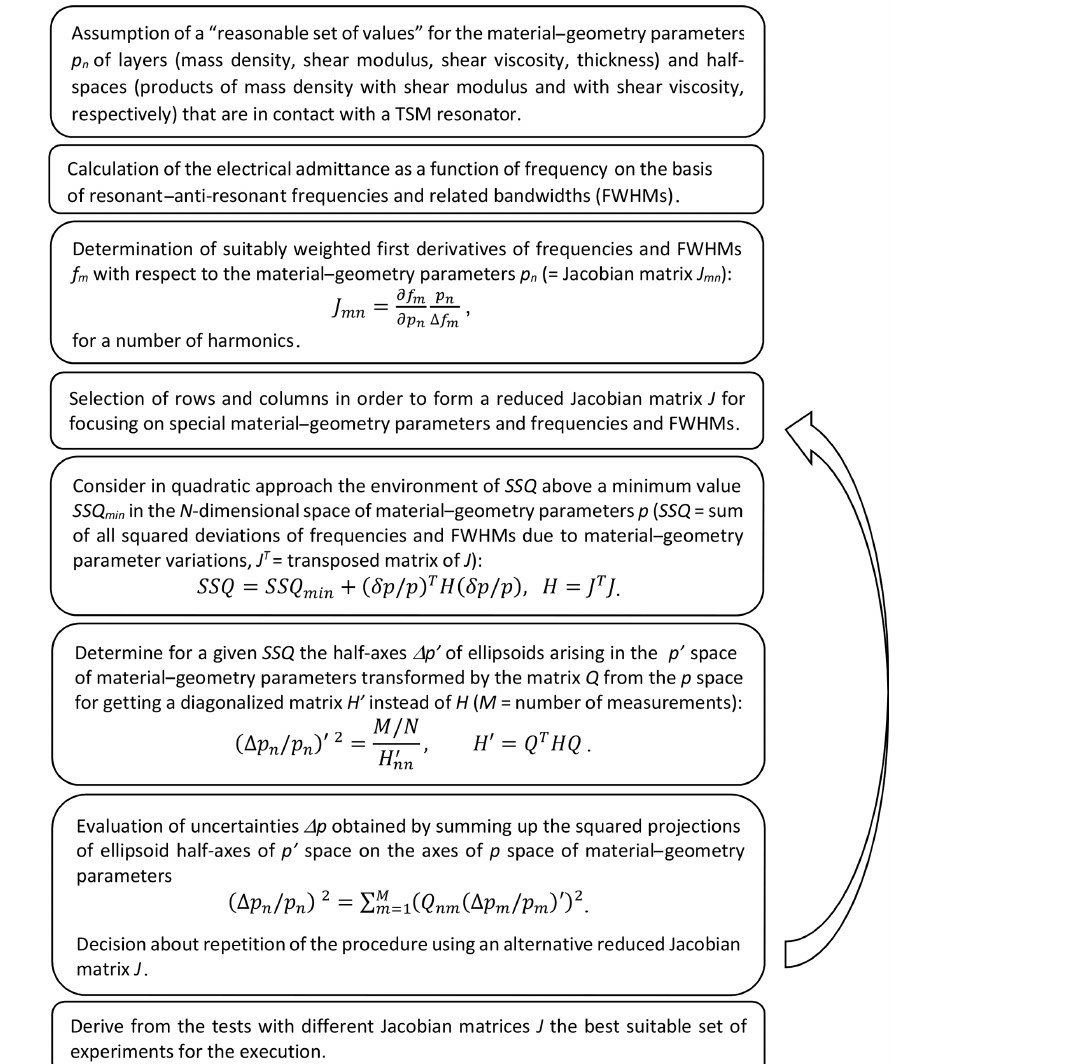
Figure 8. Flow chart of the approach to multi-parameter sensing of layers and half-spaces that are in contact with a TSM resonator.